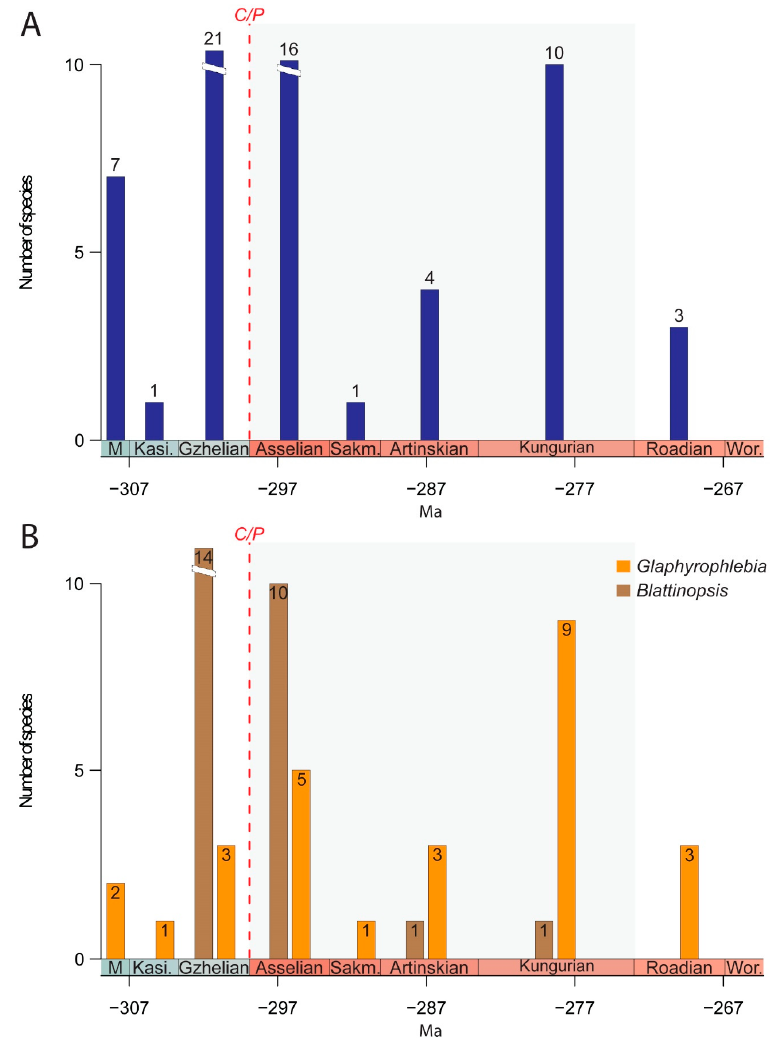
Figure 5. Diversity of major blattinopsid clades through time: ( A ) number of blattinopsid species by stage; and ( B ) number of species of Glaphyrophlebia and Blattinopsis by stage. Data from https://paleobiodb.org ( last access the 19 October 2022). Abbreviations: C/P = Carboniferous/Permian boundary, Kasi. = Kasimovian, M = Moscovian, Sakm. = Sakmarian, Wor. = Wordian.